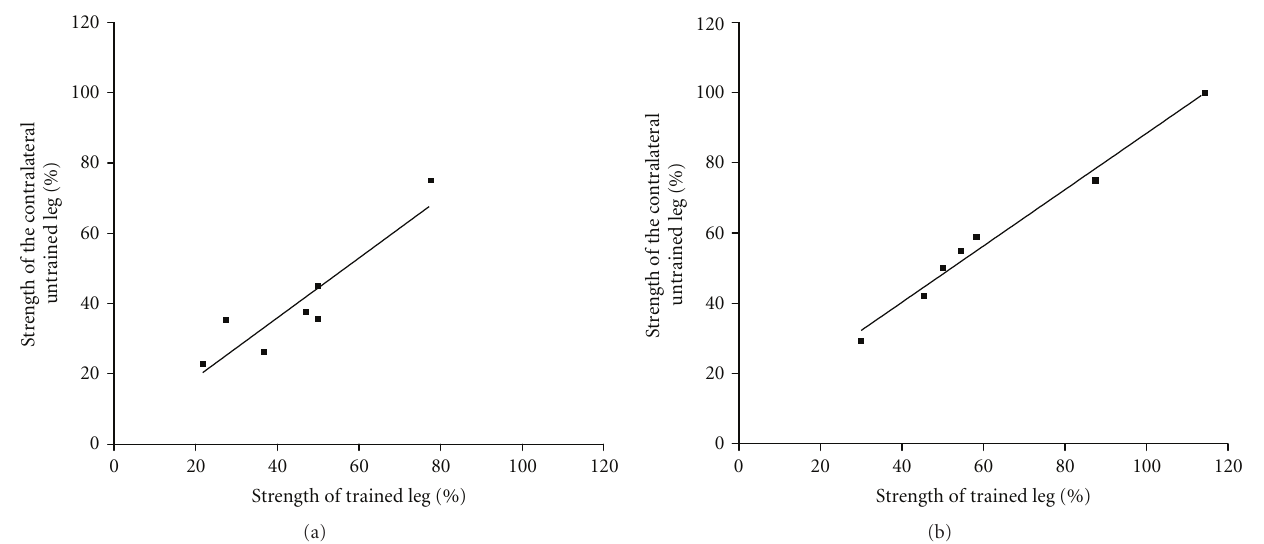
Figure 2: Mean strength (expressed as a percentage change) of the trained right and untrained left leg post training, for ST (a) and ST + V (b)